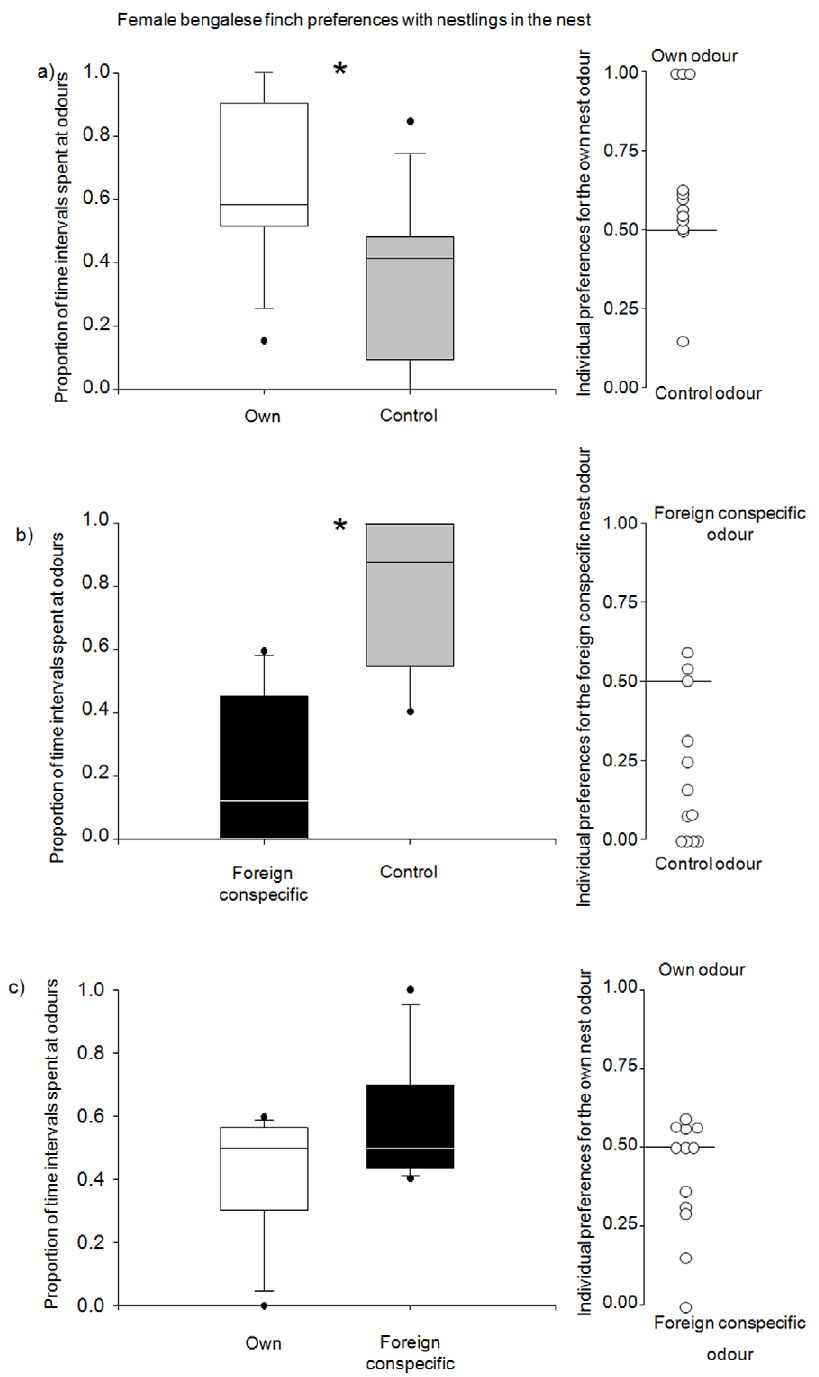
Figure 2. Female Bengalese finch preferences in three olfactory choice tests. Females were tested in the different test situations (a–c), with always having the choice between two different odours. The average (left side) and individual results as dots (right side) of the odour preference test for the adult breeding Bengalese finch females with 12 day old nestlings in the nest, when tested with a) own nest odour against control odour (Wilcoxon-test, N=12, Z= 2 2.227; p=0.026), b) foreign conspecific nest odour against control odour (Wilcoxon-test, N=12, Z= 2 2.681, p=0.007) and c) own nest odour against foreign conspecific nest odour (Wilcoxon-test, N=12, Z=1.481, p=0.139). doi:10.1371/journal.pone.0036615.g002 guttata ) and twelve pairs of Bengalese finches ( Lonchura striata var. domestica ) bred and successfully reared chicks (average brood size during nestling phase; ZF: 2.5 chicks 6 1.2 SD; BF: 3.2 chicks 6 1.6 SD). Food and water were provided ad libitum at both sides of